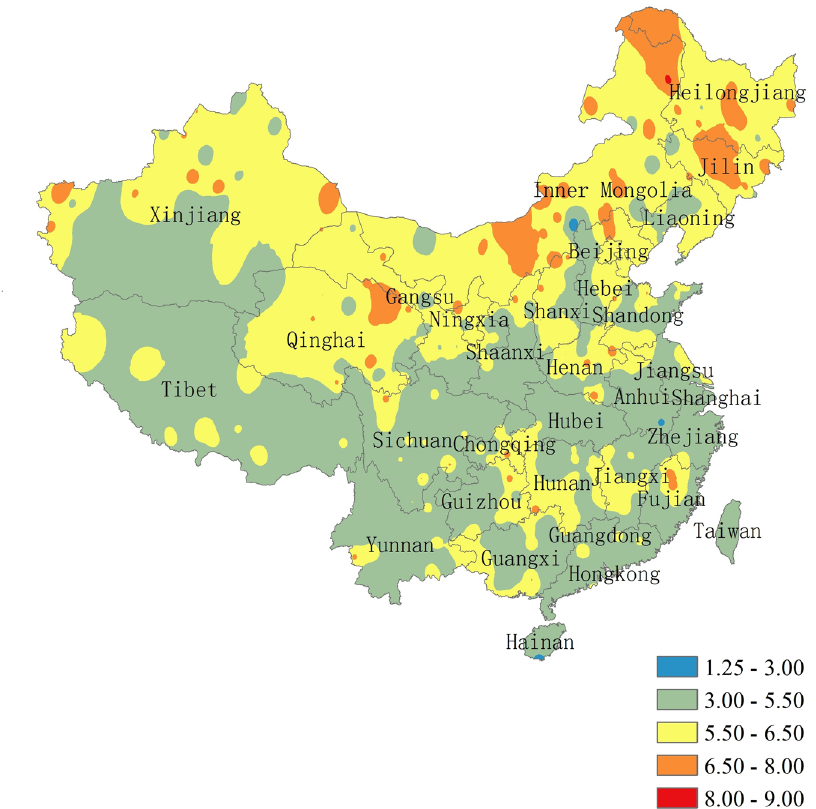
Figure 1. Variability of climate system dynamics in China from 1960 to 2013. The legend indicates value of fractal dimension which is used to depict variability, higher fractal dimension indicates higher variability. The map was generated by the software ArcGIS 10 81